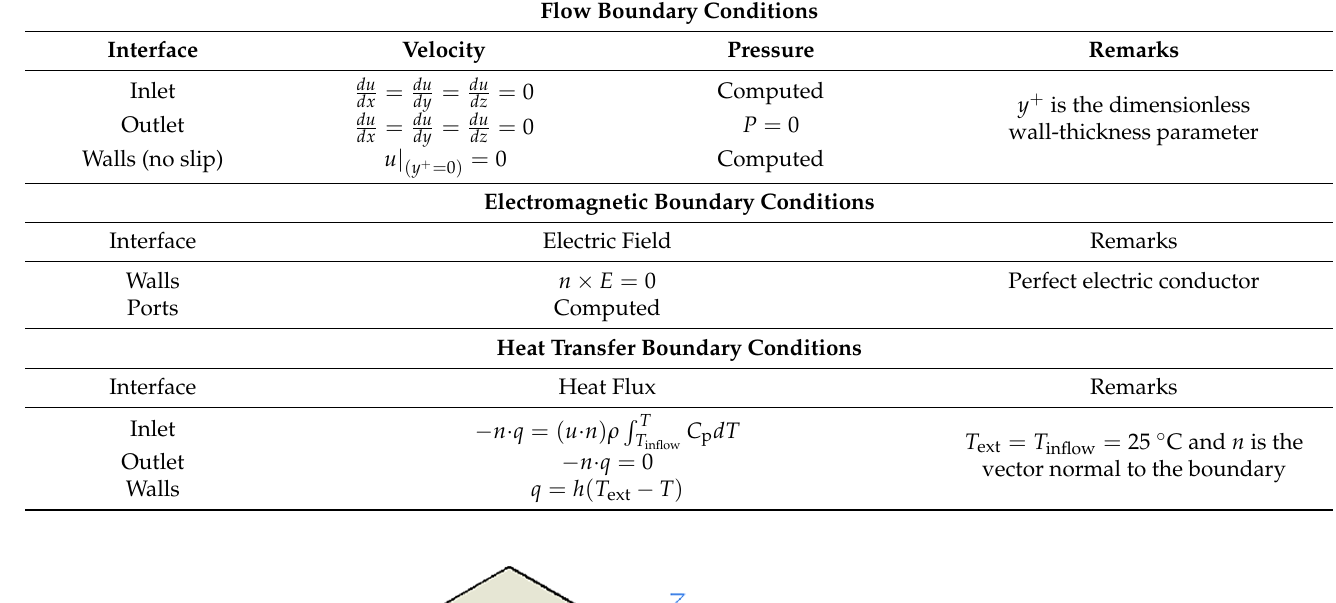
Table 2. Boundary conditions applied for the numerical calculations.